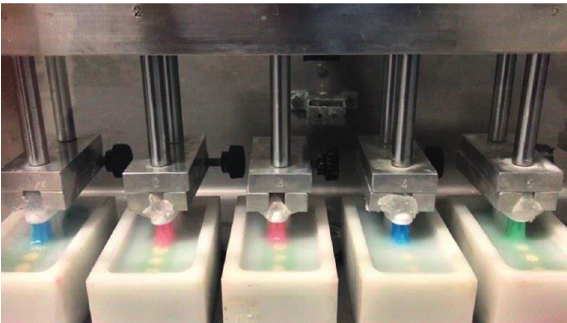
Figure 1: Plastic tubs with the dies accommodated, fitted to the brushing